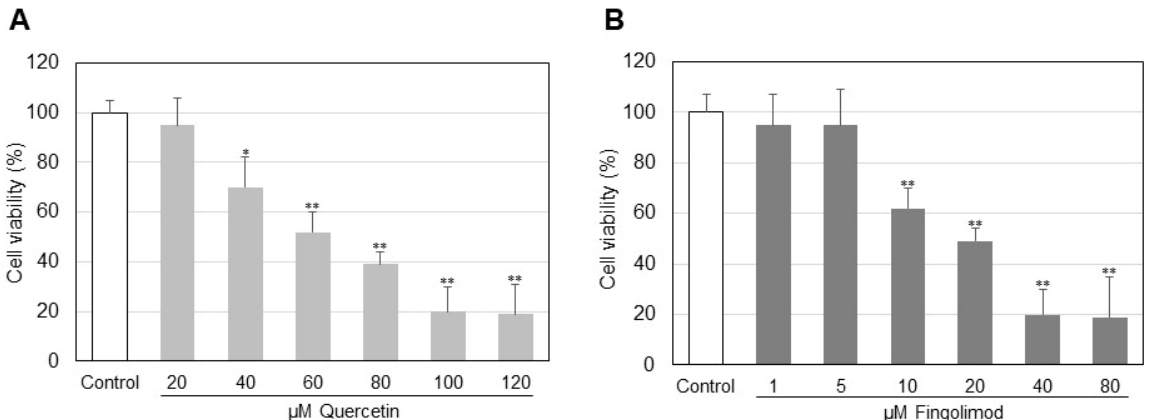
Figure 1. Viability of HepG2 cells treated for 24 h with quercetin in a concentration range of 20–120 µM ( A ) and fingolimod ( B ) in a concentration range of 1–80 µM. Statistical significance is presented as comparison of treated cells with controls. * p < 0.05; ** p < 0.001.